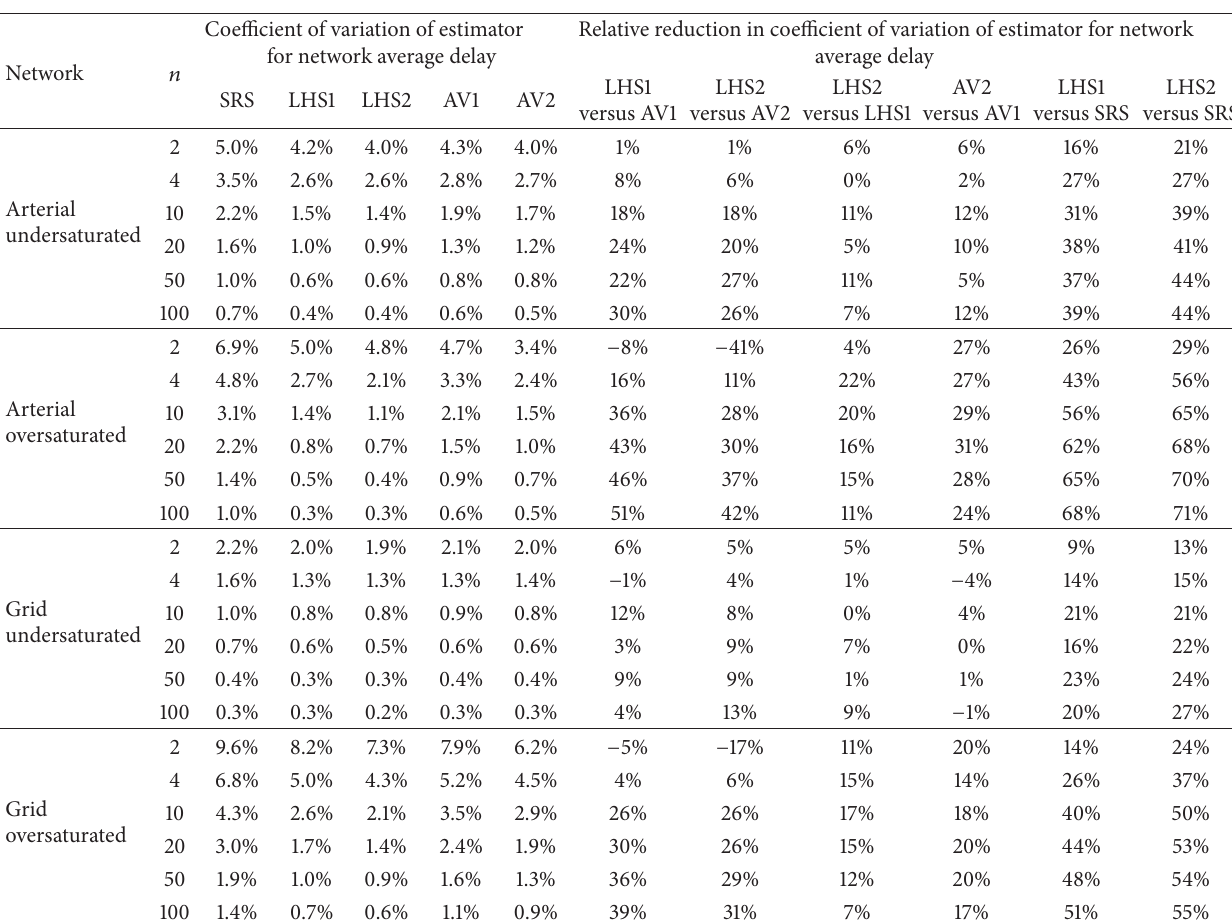
Table 2: Coefficient of variation of estimators of network performance under SRS, LHS1 and LHS2, and AV1 and AV2.